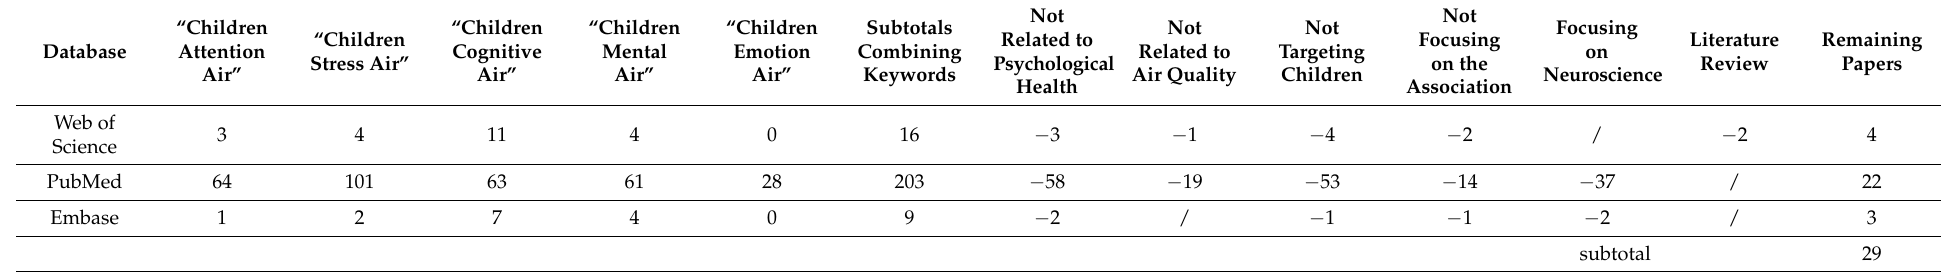
Table 3. Paper Selection